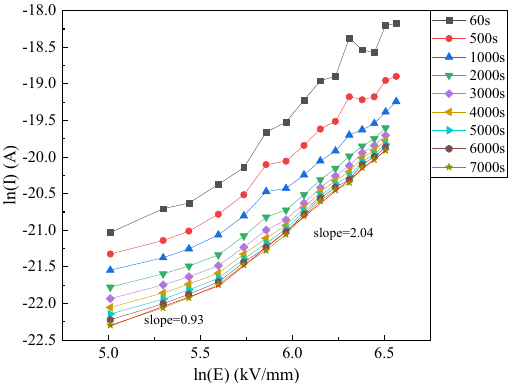
Figure 4. Electric field dependence of Ic in PP films.